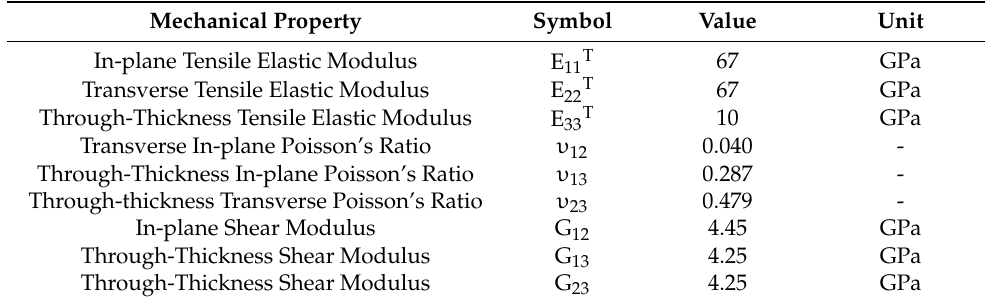
Table 4. Material properties for the [+45 ◦ /0 ◦ / − 45 ◦ /90 ◦ ] 32S composite laminate used in finite element analysis (FEA).